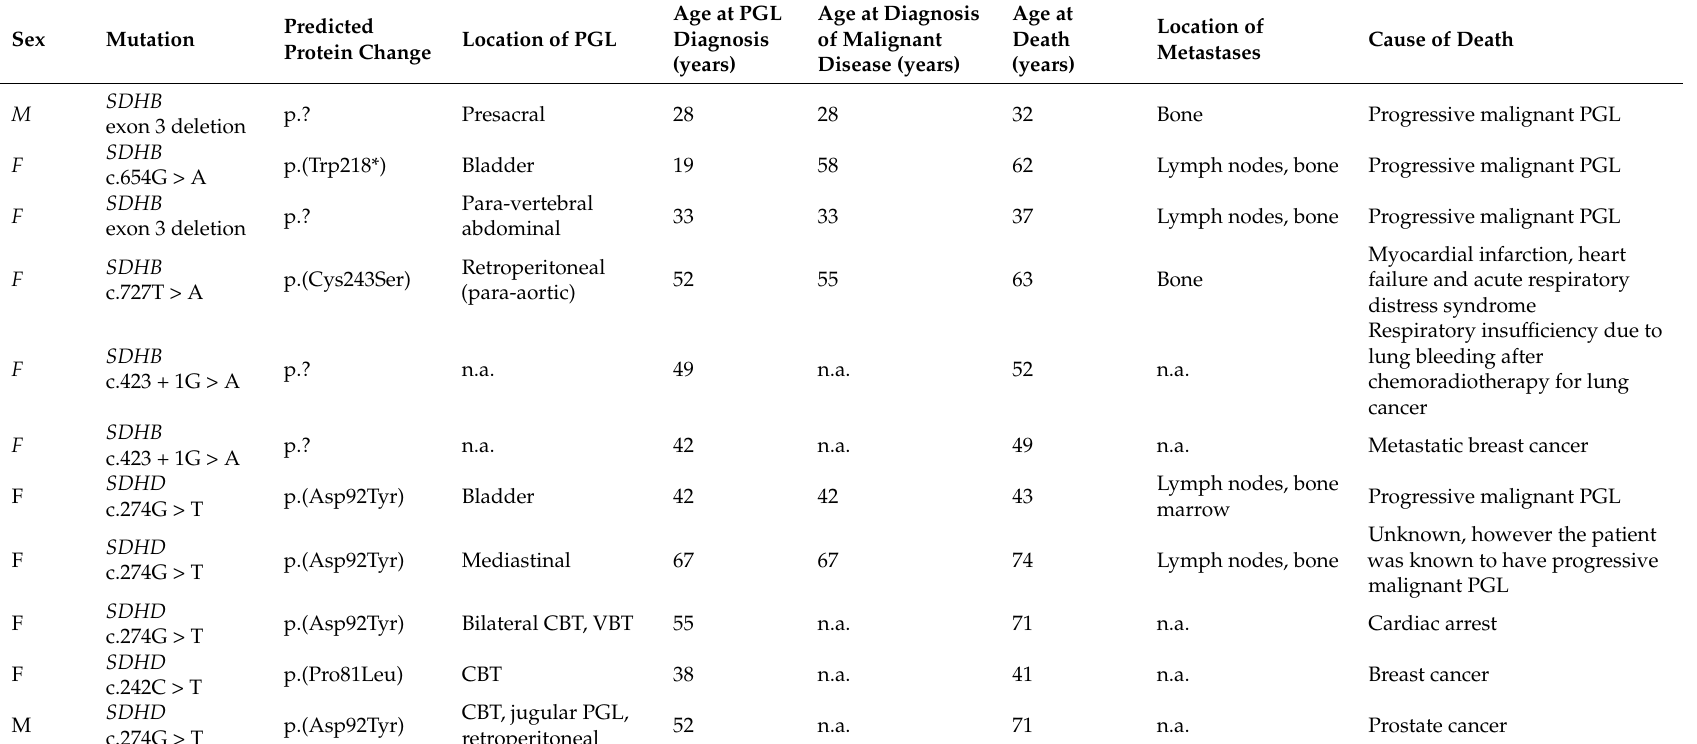
Table 2. Details of six SDHB and five SDHD variant carriers who died during